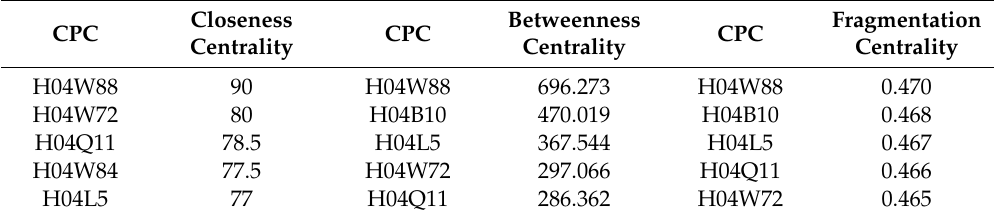
Table 4. Top five CPC codes of 5G optical